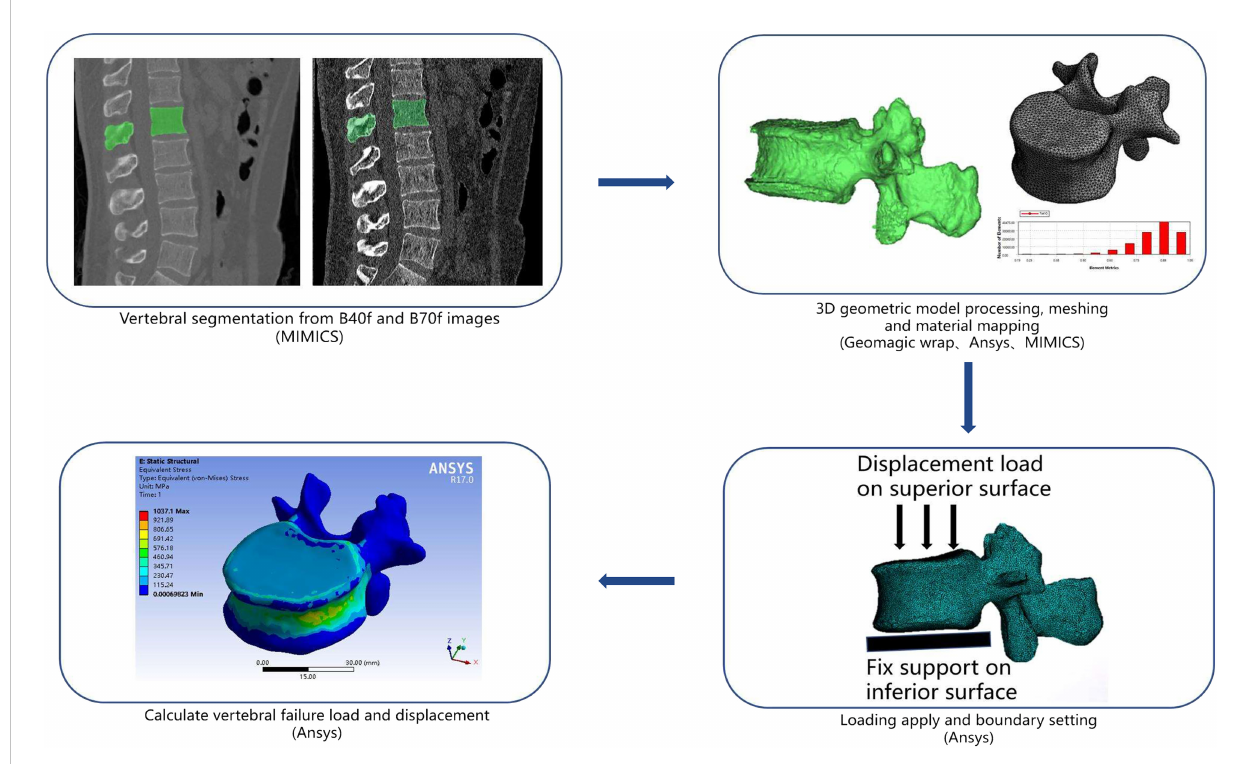
FIGURE 1 Schematic representation of geometry extraction, modeling, and analysis methodology in the current